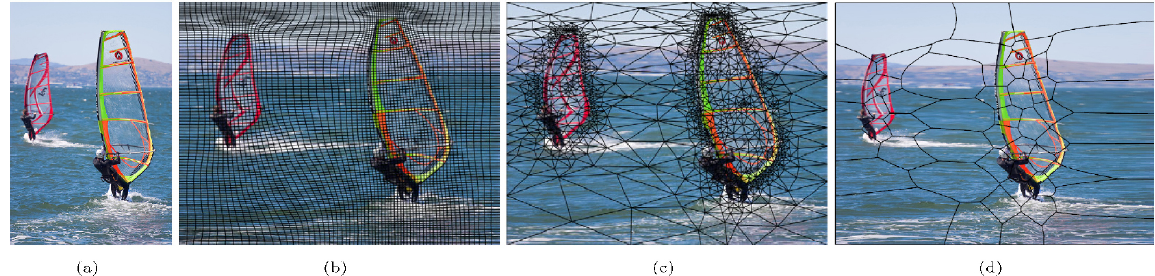
Fig. 8 Comparison between different FEM-based warping methods, resizing an image to 200% of the original width. (a) Input. (b, c) Results from the DG FEM-based warping method using quadratic power polynomials on a quadrilateral mesh (6767 DOFs), and an adaptive triangular mesh (1325 DOFs neglecting the number of constraints for gluing elements with 2612 elements) from Ref. [29]. (d) Result using the proposed poly-FEM warping method (460 DOFs, 50